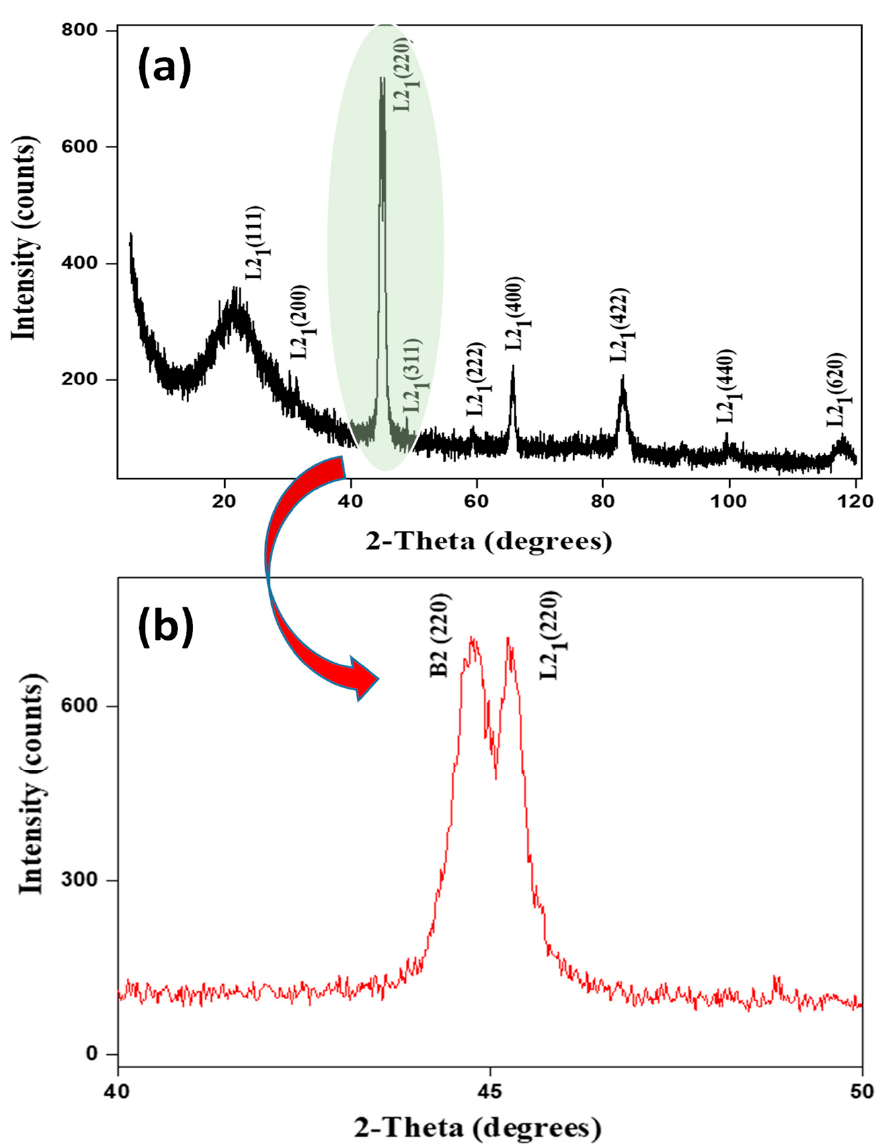
Figure 2. ( a ) X-ray diffraction (XRD) diffractograms at room temperature of Co 2 MnGe, and ( b ) XRD diffraction patterns of Co 2 MnGe (enlargement of (220) peaks).